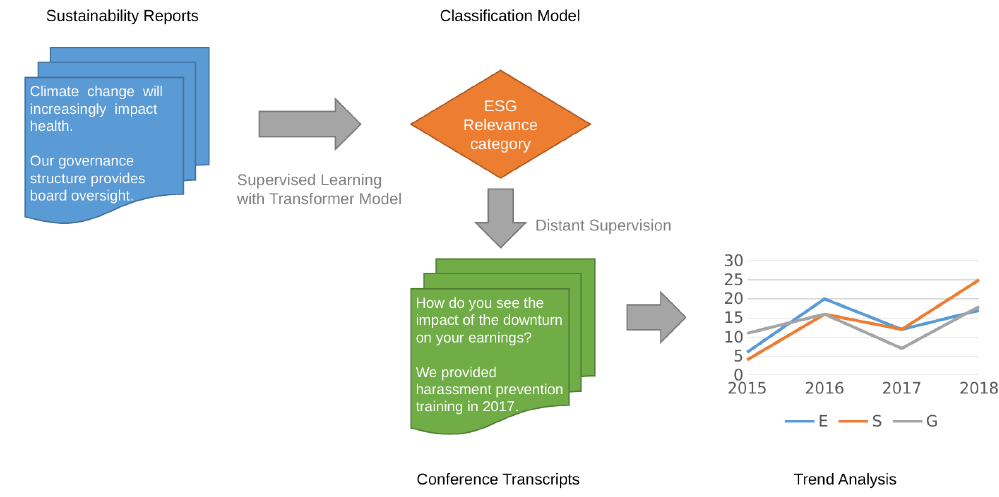
Figure 1. Approach Overview. A classification model is learned from corporate sustainability reports and applied to earnings conference call transcripts for detecting ESG